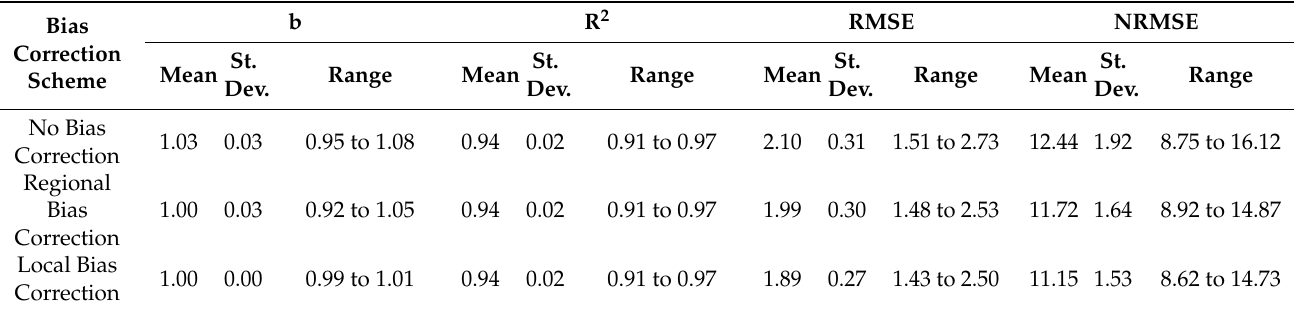
Table 6. Mean and range values of the accuracy metrics relative to NASA POWER solar radiation with and without bias correction for the full data set of all 14